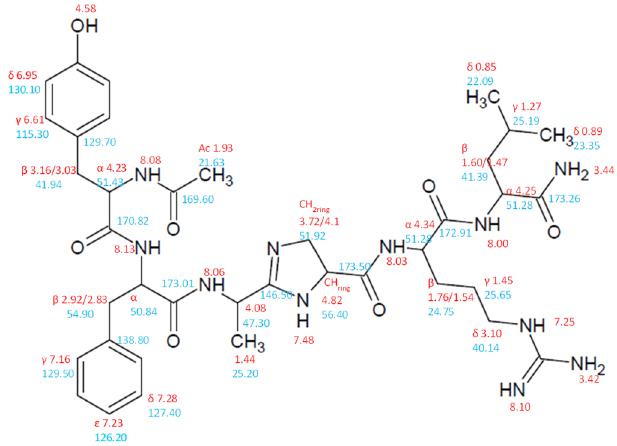
Figure 4. Structure of PPK-Jo with shifts of H (red) and C (blue) atoms displayed. Yield of the crude peptide attached to the polymer support, calculated from weight gain, was approximately 90–95% in several trials on the scale from 0.05 mmol to 0.125 mmol. Yield: 9–12% total of repurified product (HPLC) depending on the scale of synthesis. For the scale of 0.05 mmol, the yield was 10% (5.12 micromoles).